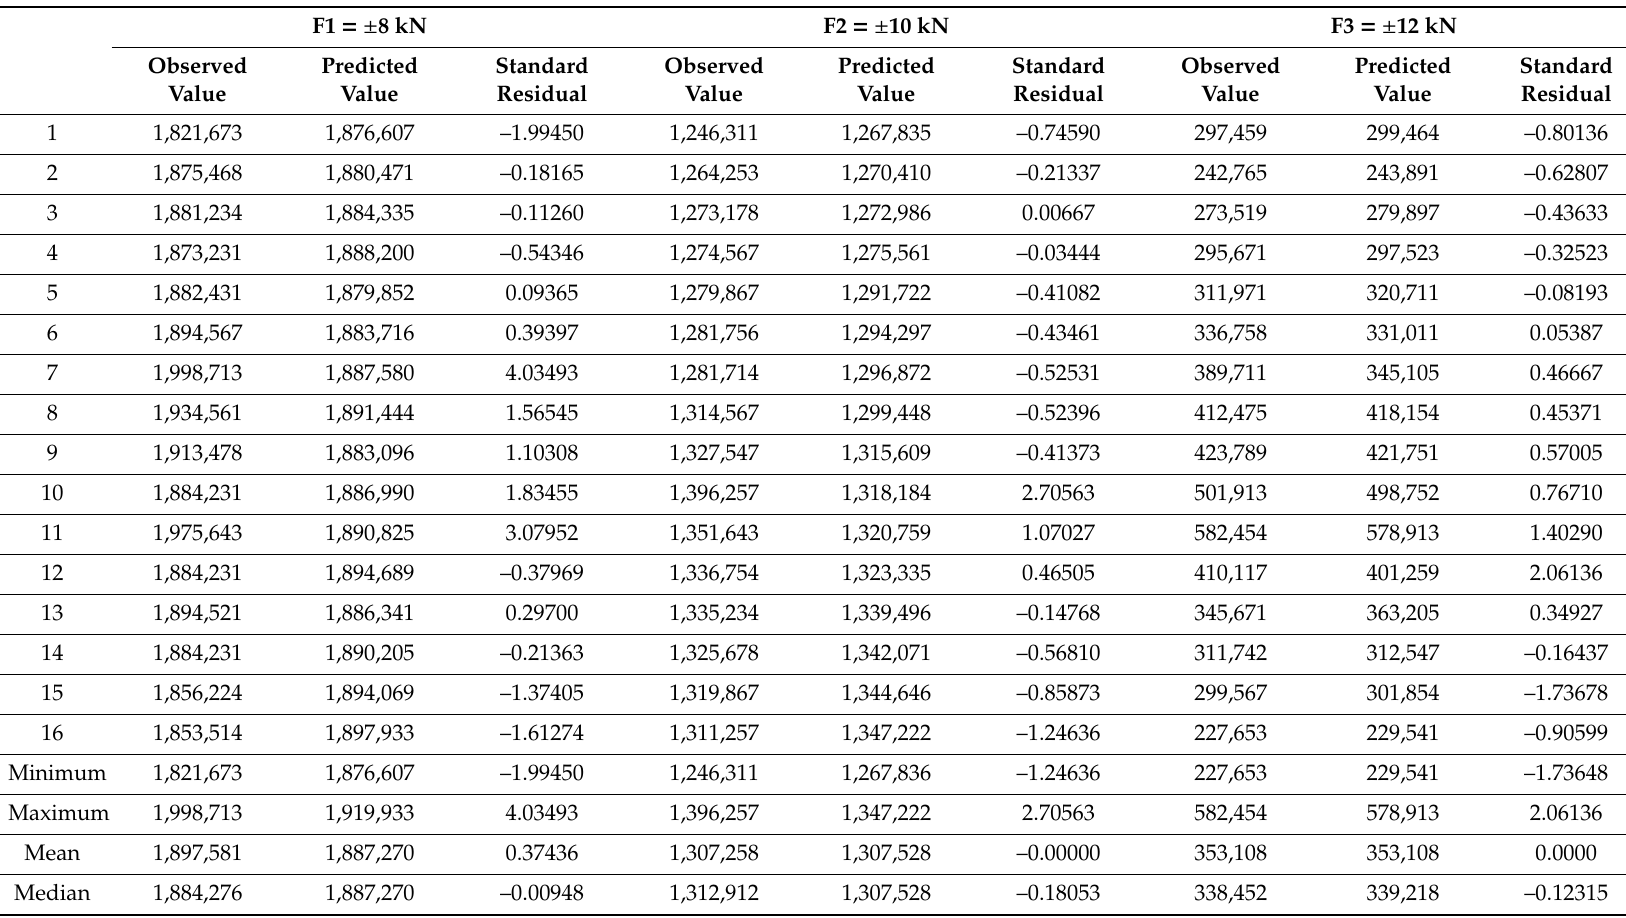
Table 9. Residual analysis following experimental data processing using